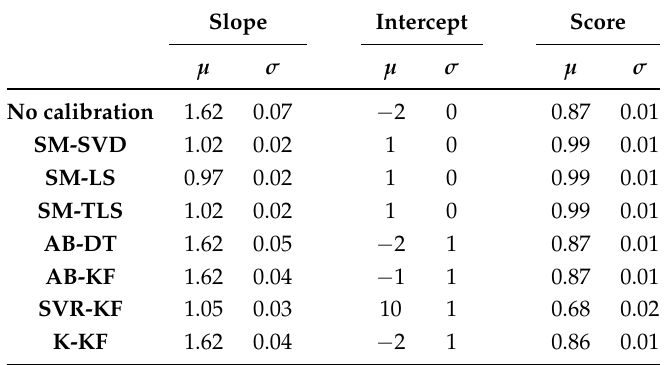
Table 4. Mean ( µ ) and standard deviation ( σ ) of the parameters of the error model and the regression score, computed on the entire time interval of drift, over the 16 nodes of the network. The observations that can be made with these values are identical to those of Table 1. This table also seems to confirm that there is a bias for SVR-KF as the standard deviation of the slope and intercept among sensors is small, with mean slope close to 1 but a mean intercept equal to 10. However, the poor mean score of the regression invites to be careful with this statement. Slope Intercept Score